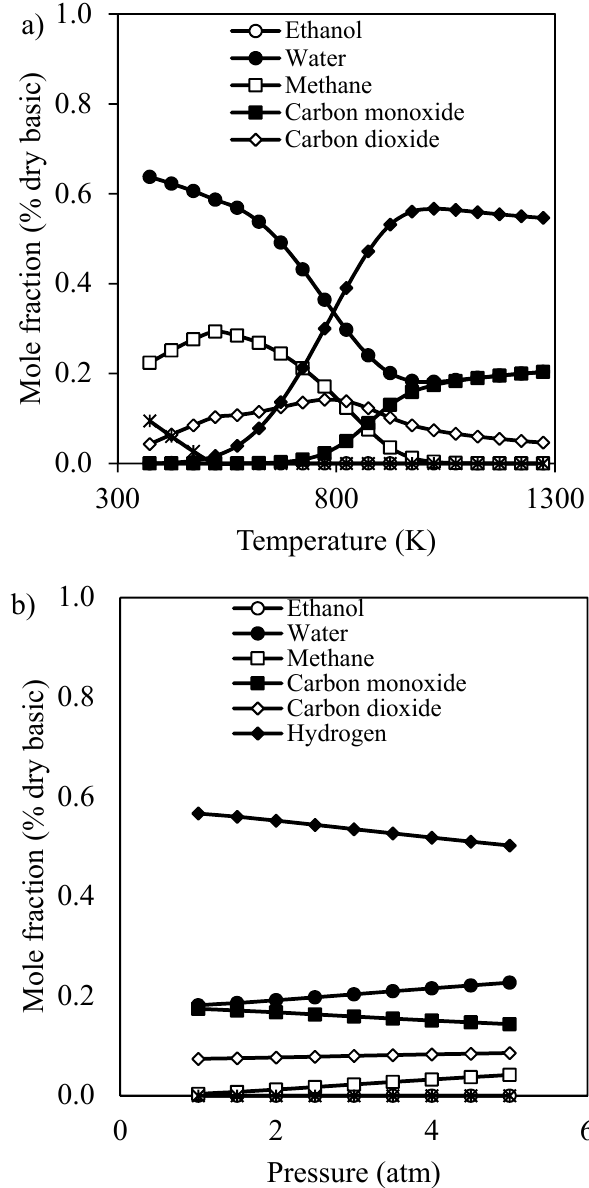
Figure 4. Mole fraction of product stream at a steam to ethanol ratio of 3 for ( a ) effect of temperature ( P = 1 atm), and ( b ) effect of pressure ( T = 1023 K).